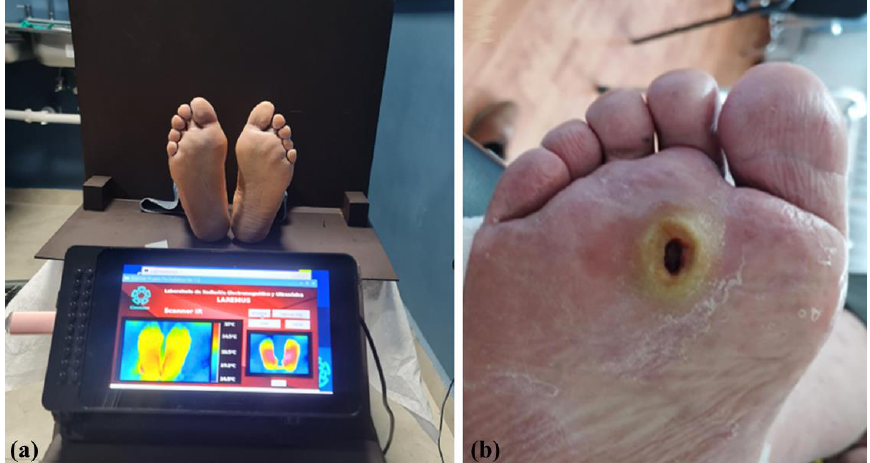
Figure 3. ( a ) IR Scanner device in a study with a diabetic patient. ( b ) Photograph of a characteristic diabetic patient ’ s lesion.